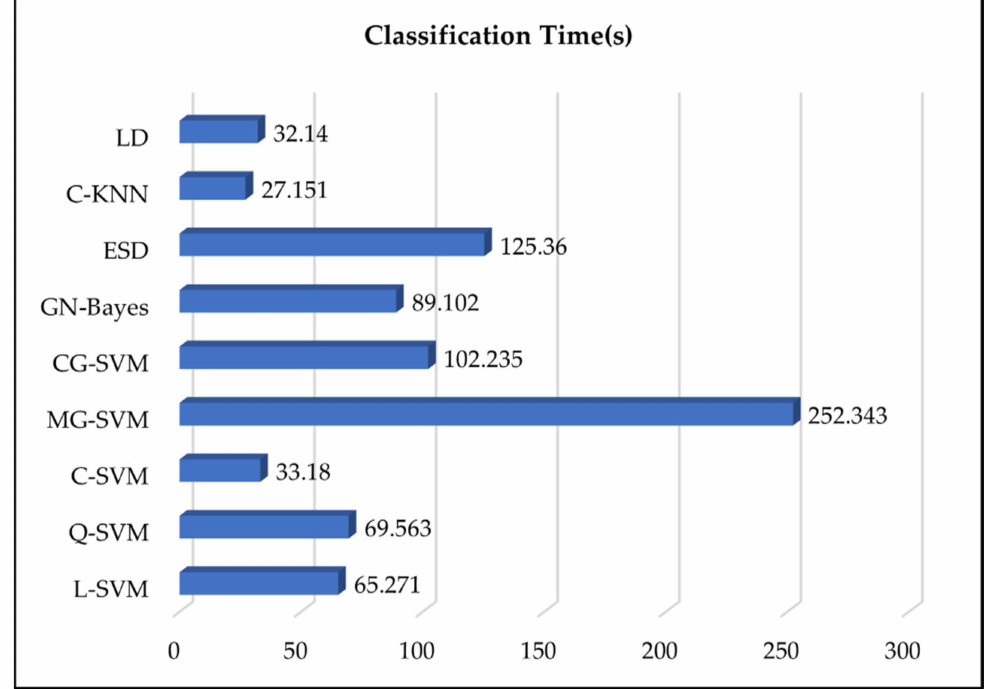
Figure 7. Computational time comparison of utilized machine-learning classifiers.